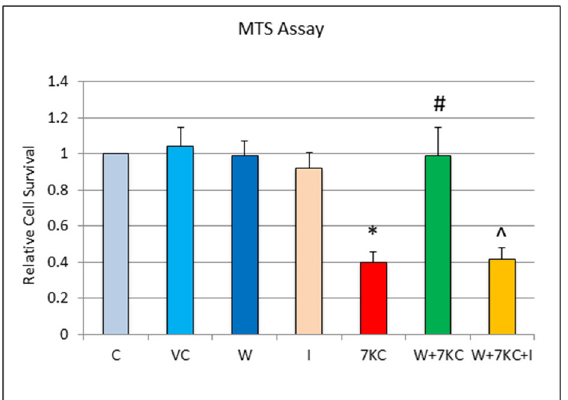
Figure 1. Effect of withanolide A on 7KC-induced cytotoxicity, determined by MTS assay. hCMEC/D3 cells were treated with vehicle only, 7KC only, withanolide A only, pre-treated with 1 μM withanolide A for 1 h, followed by co-incubation with 30 μM 7KC for 24 h or pre-treated with 1 μM withanolide A plus 10 μM mifepristone for 1 h, followed by co-incubation with 30 μM 7KC for 24 h. Co-treatment of cells with withanolide A results in reduction in 7KC-induced cytotoxicity. The protective effect of withanolide A was abolished when cells were co-treated with withanolide A and mifepristone plus 7KC. C: Control, VC: Vehicle control, W: 1 μM withanolide A, I: 10 μM mifepristone, 7KC: 30 μM 7KC. W+7KC indicates co-treatment of withanolide A plus 7KC. W+7KC+I indicates co-treatment of withanolide A plus 7KC plus mifepristone. Data are represented as mean ± SD ( n = 4). * Significant difference compared to controls. # Significant difference compared to 7KC ^ Significant difference compared to withanolide A + 7KC (all p < 0.05).